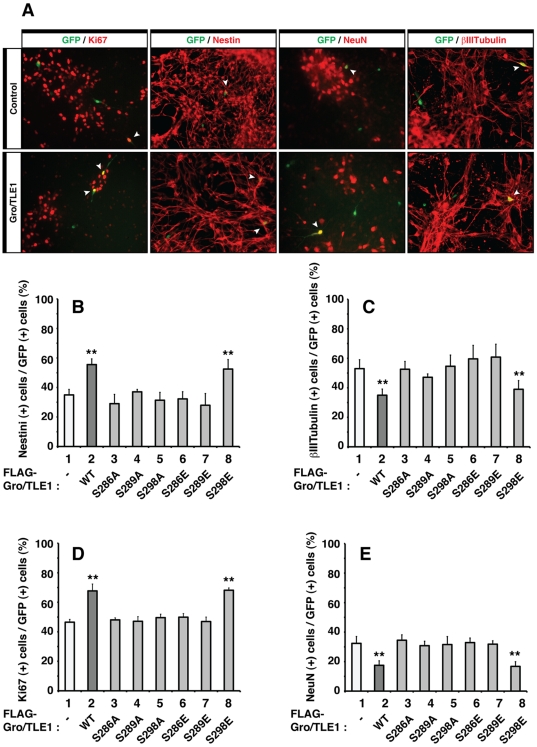
Effect of SP domain mutations on Gro/TLE1 ability to inhibit cortical neuron differentiation.(A) Primary cultures of E13.0 mouse embryonic cortical progenitor cells were transfected with plasmids encoding either GFP alone (Control; top row) or a combination of GFP and wild type Gro/TLE1 (Gro/TLE1; bottom row). After fixation, cells were subjected to double-labeling analysis of the expression of GFP (green) and either Ki67, nestin, NeuN, or type III β-tubulin (βIIItubulin) (red), as indicated. Arrowheads point to examples of double-labeled cells. (B–E) Quantitation of the percentage of GFP-positive cells that co-expressed nestin (B), type III β-tubulin (C), Ki67 (D), or NeuN (E) in the absence or presence of wild type or mutated forms of Gro/TLE1. The anti-neurogenic activity of Gro/TLE1 was impaired by the SP mutations S286A, S289A, and S298A. Results are shown as the mean±the standard deviation (>500 cells were counted in each case; n≥5; **, P<0.001 using the Student's t test).